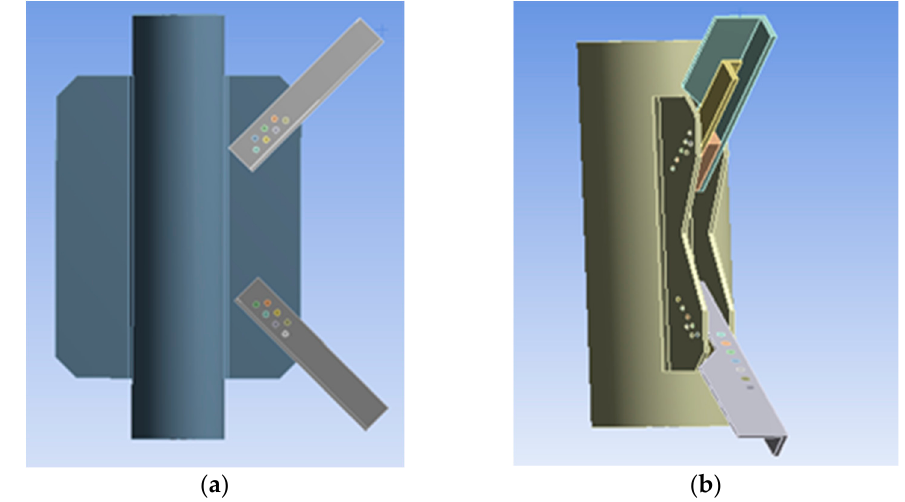
Figure 1. ( a ) Joint model of pipe single-limb single-plate; ( b ) joint model of pipe double-limb double-plate.